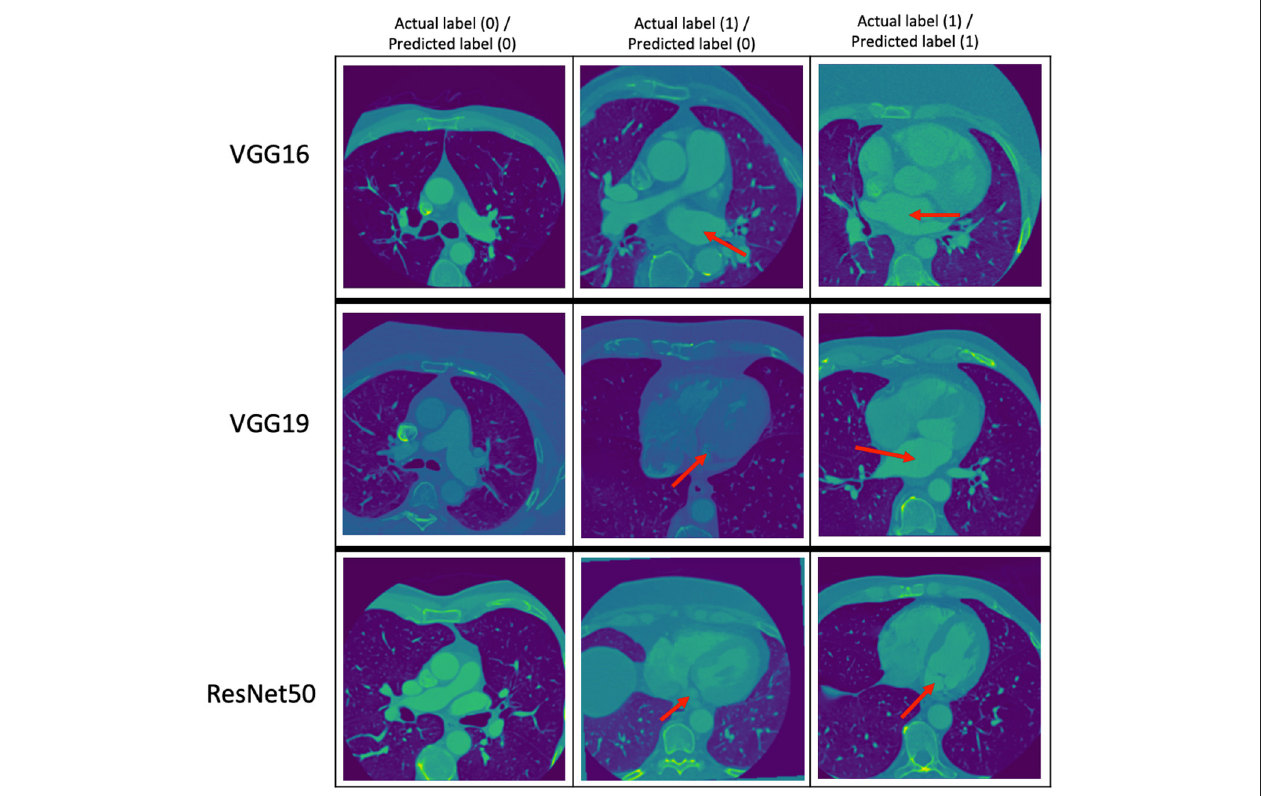
FIGURE 3 | Some examples of the prediction of the classification models. The top, middle, and bottom rows correspond to the predictions of the VGG16, VGG19, and ResNet50 models, respectively. The red arrows point to the LA. The middle column shows images with LA that the classification models got wrong.